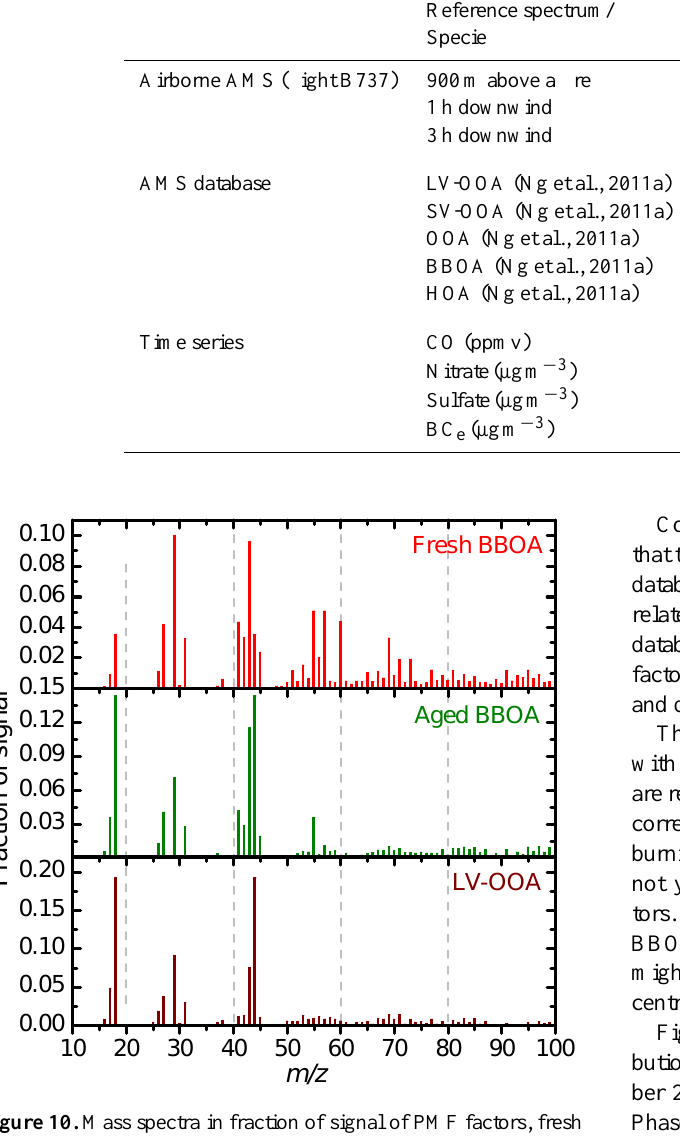
Figure 10. Mass spectra in fraction of signal of PMF factors, fresh BBOA, aged BBOA, and